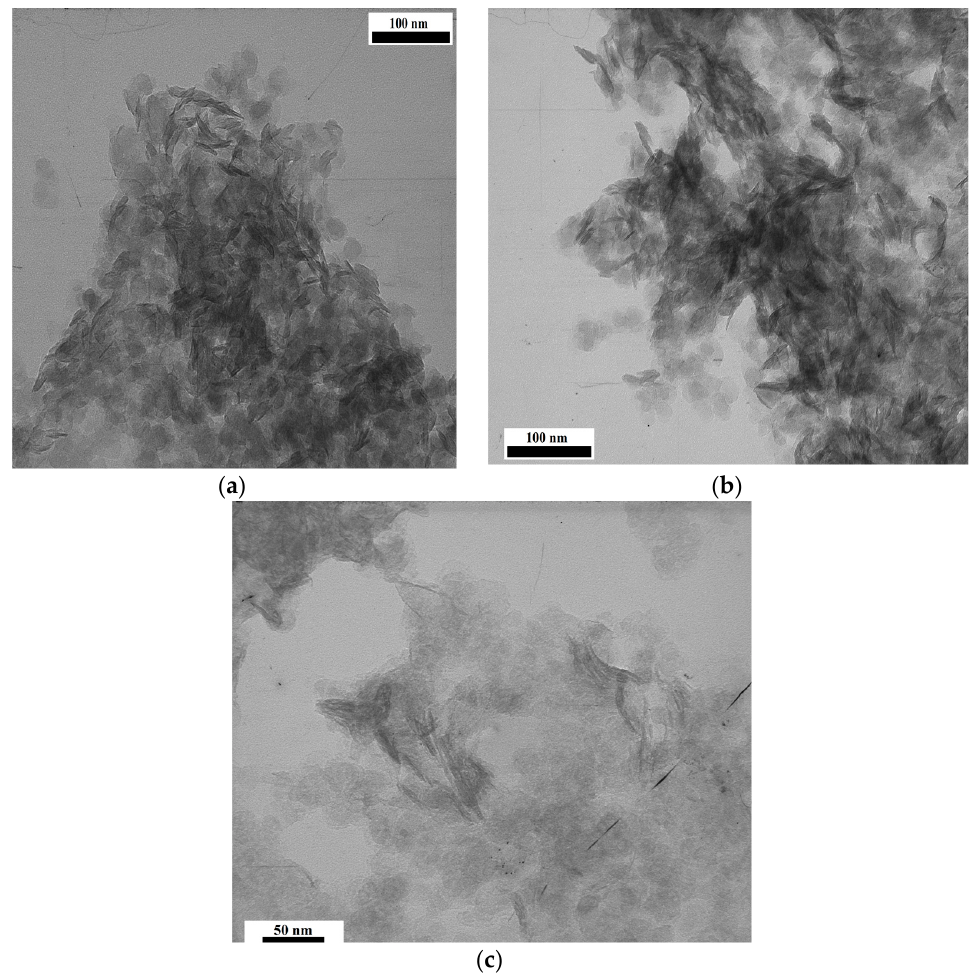
Figure 3. TEM images of as-synthesized lanthanide-containing layered double hydroxides: ( a ) Ni/AlHo; ( b ) Ni/AlTm; ( c )